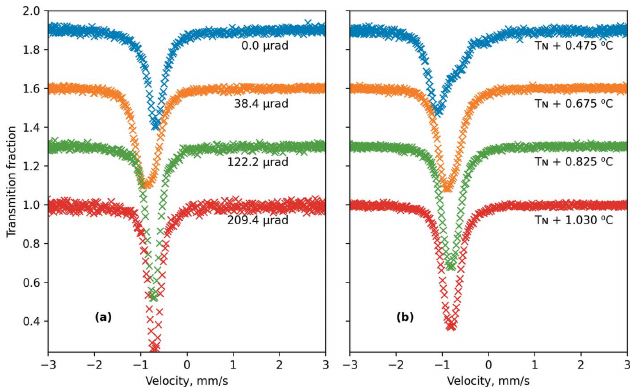
Figure 3 Mo¨ssbauer spectra of the standard K 2 Mg 57 Fe(CN) 6 absorber collected ( a ) at temperature T = 76.230 (cid:4) C ( T N + 1.03 (cid:4) C) for various angular positions (cid:4) and ( b ) at (cid:4) = 52 m rad for various temperatures. For better visibility, each subsequent spectrum is shifted vertically by 0.30 ( i.e. by 30% of transmission).